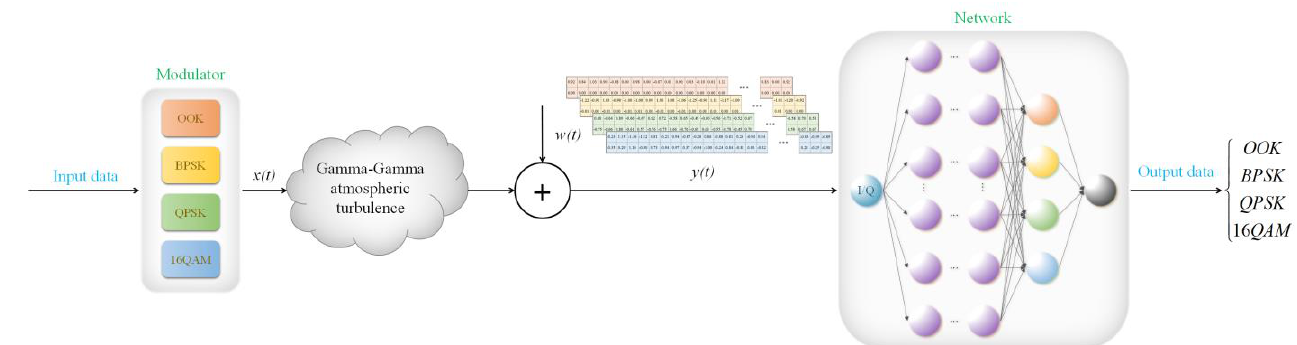
Figure 4. Proposed optical communication system.